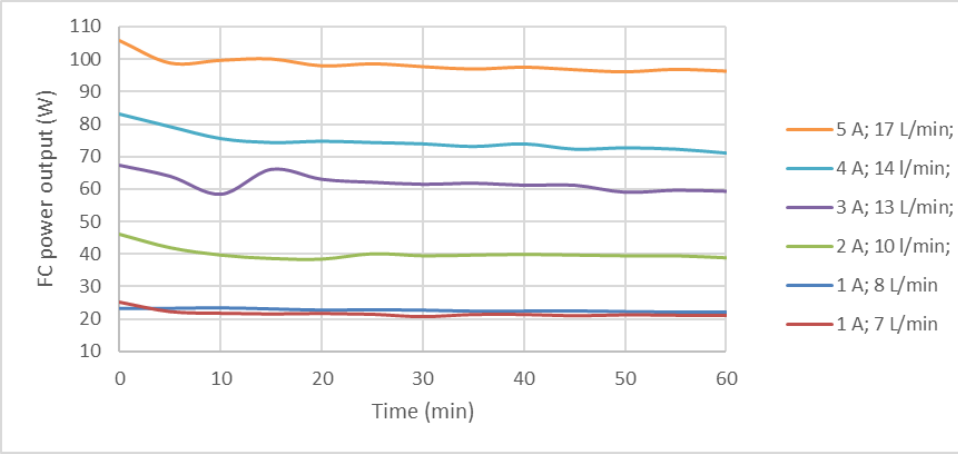
Figure 9. The measured power as a function of time for the different cases with varying currents and ventilation flow rates.